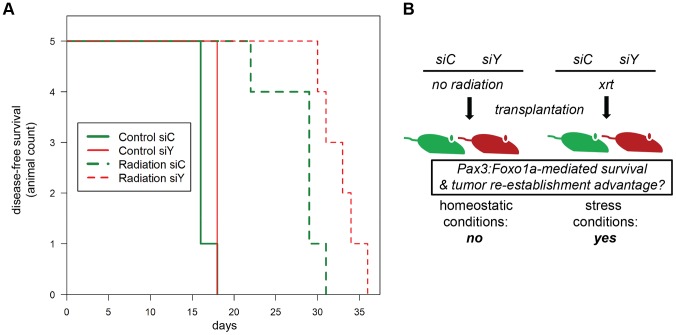
Treatment-related implications for dynamic oncogene expression in rhabdomyosarcoma in vivo.(A) Kaplan-Meier survival analysis for disease-free survival of mice implanted with pre-irradiated (10Gy) primary murine aRMS tumor cells treated with Pax3:Foxo1a siRNA (siY) or control siRNA (siC), n = 5 animals per cohort. The p value for the difference between siY and siC groups receiving radiation was 0.02. (B) Diagrammatic representation of results in (A).